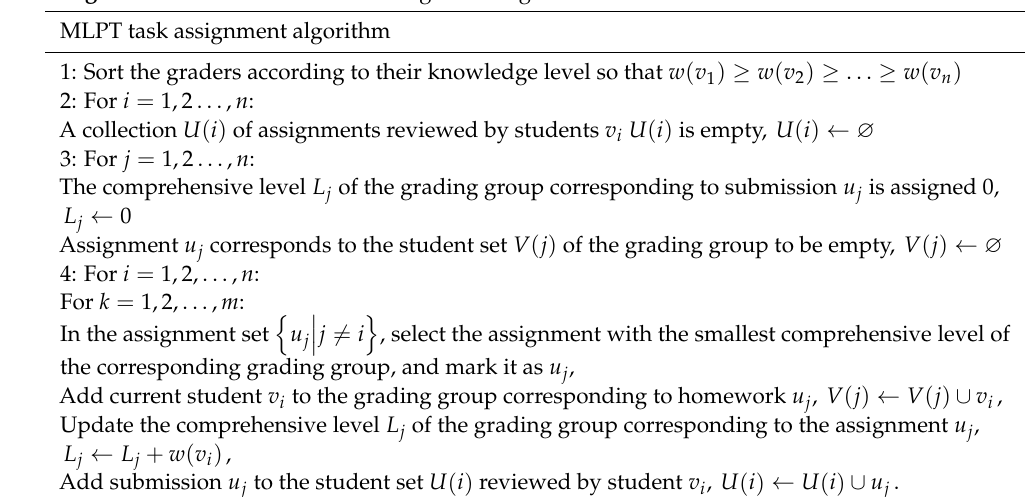
Algorithm 1. MLPT submission assignment algorithm. MLPT task assignment